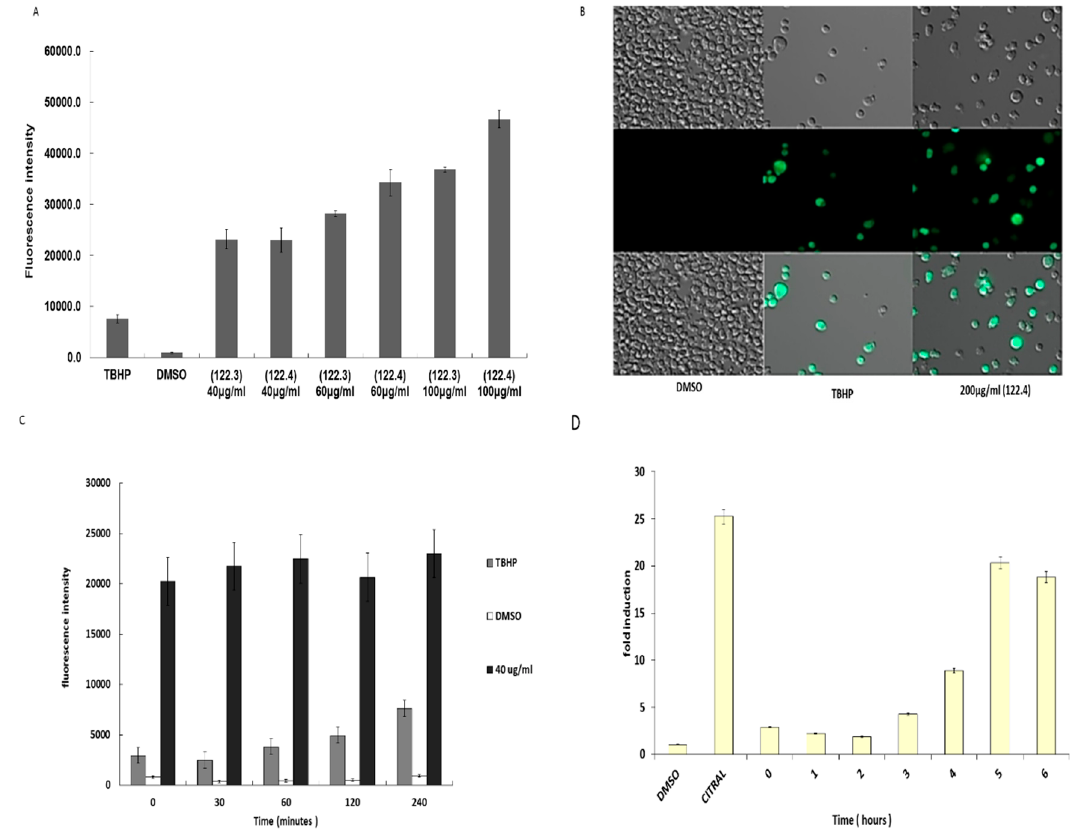
Figure 4. Effect of A. graveolens fractions 122.3 and 122.4 on ROS production. ( A ) 1.5 × 10 5 BS-24-1 cells per well were incubated with 20–25 μ M of the detection dye H2DCFDA for 30 min at 37 °C, under 5% CO2 followed by the addition of different concentrations of fraction 122.3 and 122.4 or tert-Butyl hydroperoxide (TBHP) as a positive control or DMSO as a negative control. ROS production was measured according to the manufacturer instructions. The X -axis represents different treatments while the y -axis shows fluorescence intensity in arbitrary units. ( B ) Images of cells treated with DMSO, TBHP and fraction 122.4 were taken by the ZEISS ApoTome (Oberkochen, Germany). ( C , D ) Time course series of effect of fraction 122.4 on ROS production ( C ) and on activation of Caspase-3 ( D ). The X axis presents length of reaction in minutes ( C ) and hours ( D ); The Y axis presents fluorescence intensity ( C ) and fold-induction ( D ). Treatment with DMSO or Citral was stopped and measured after 4